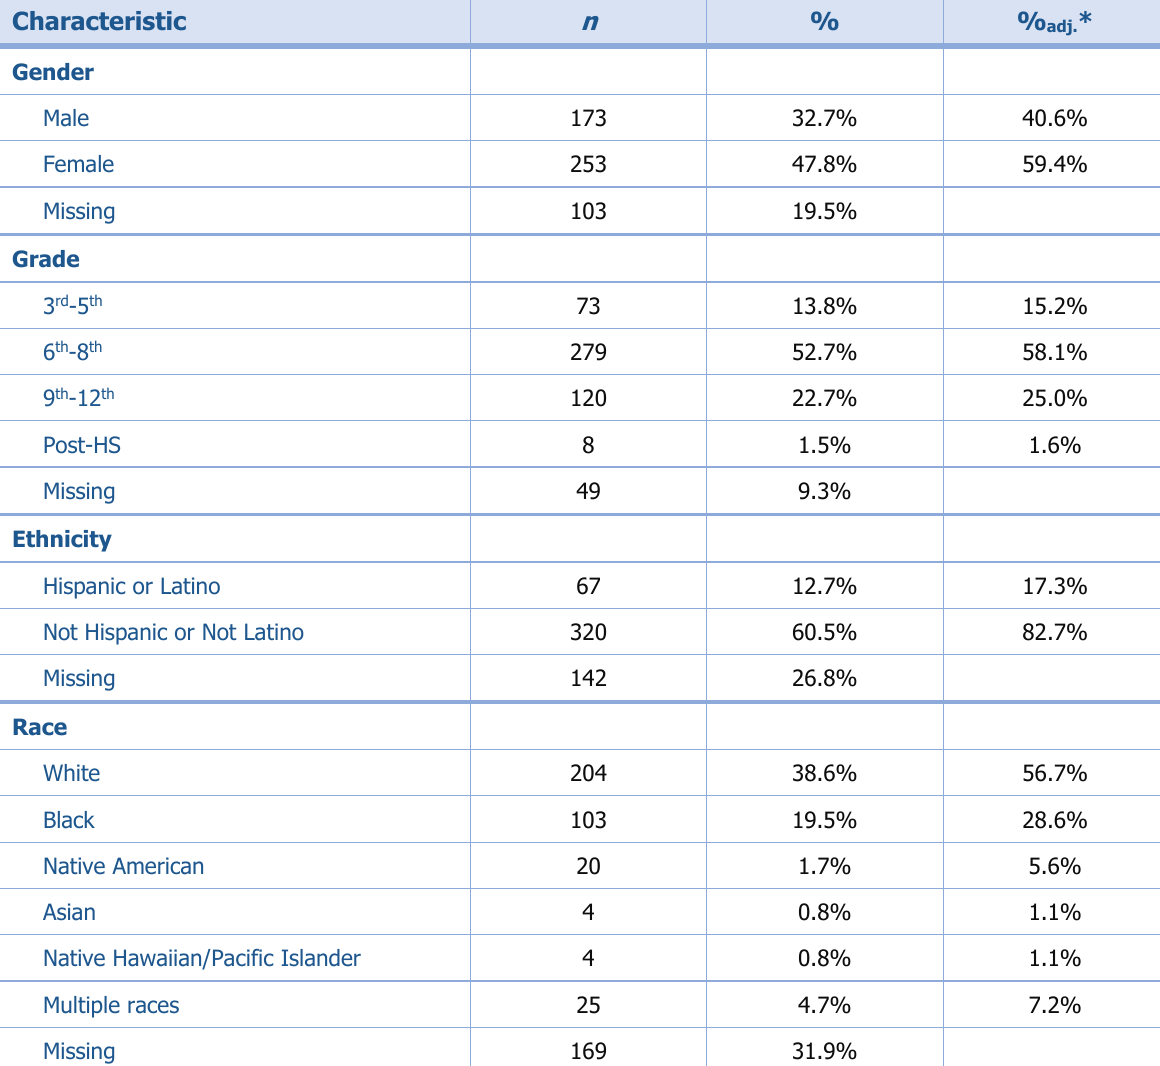
Table 1. CYFAR Participant Demographics at